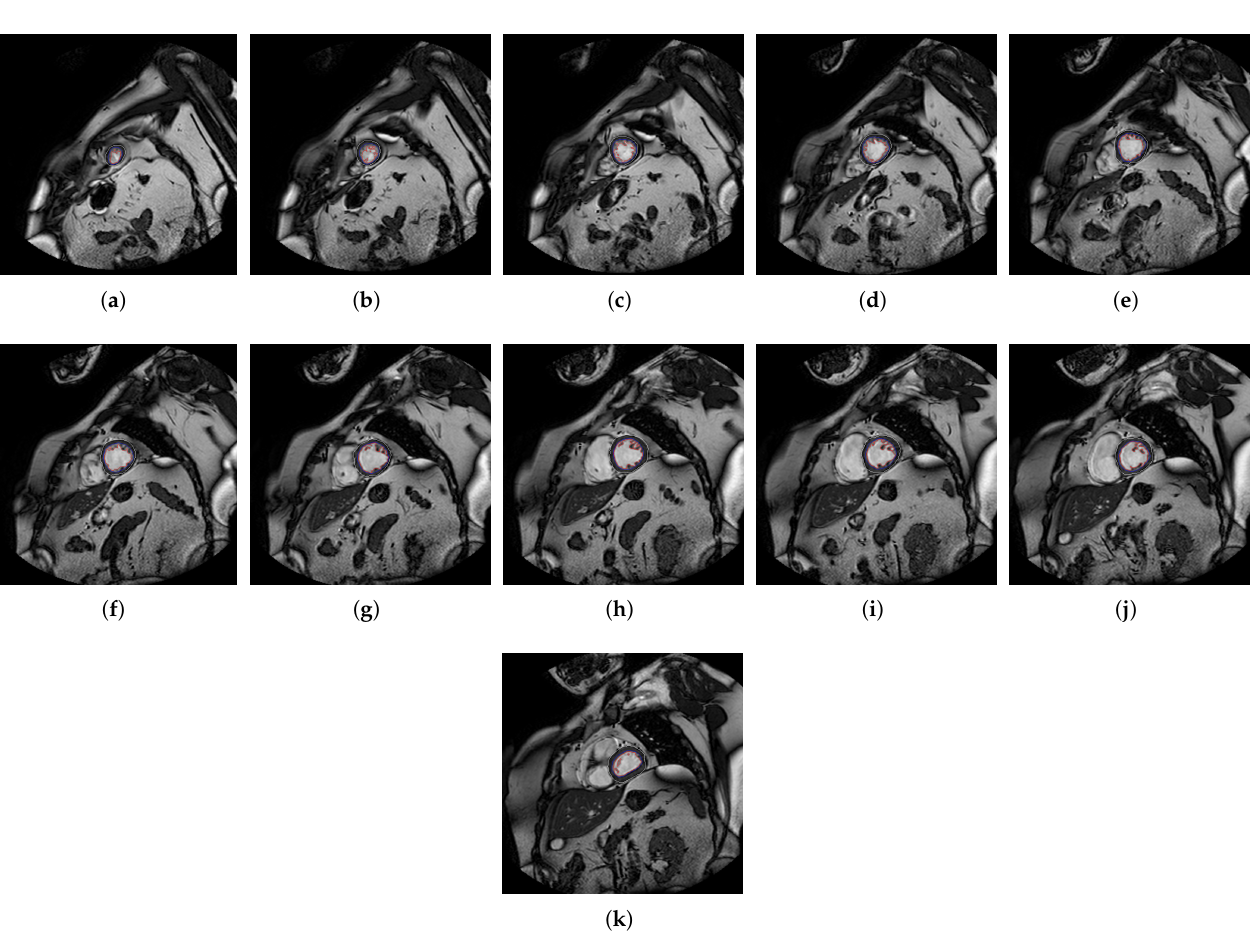
Figure 5. ( a – k ) Slices 1 to 11 of